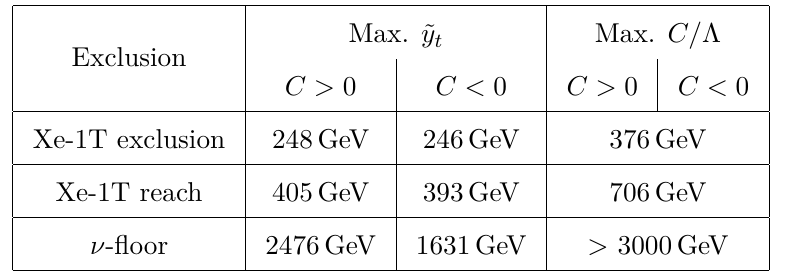
Table 1 . The masses m S at which the bounds in figure 4 intersect the regions of